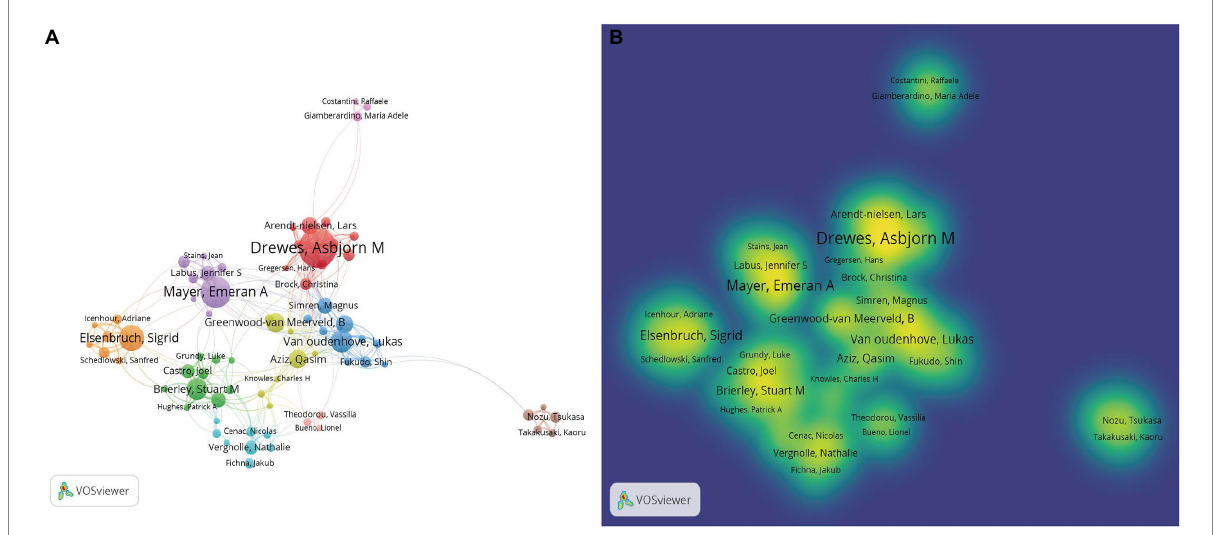
FIGURE 3 (A) The Co-authorship map of Authors in visceral pain research ( T ≥ 10). The size of node reflects the author’s co-authored papers, the link indicates the co-authored relationship between authors, and the same color of node represent the same cluster. (B) The density map of authors in Visceral Pain Research ( T ≥ 10). Notes: The size of word, the size of round, and the opacity of yellow is positively related to the co-authored papers.